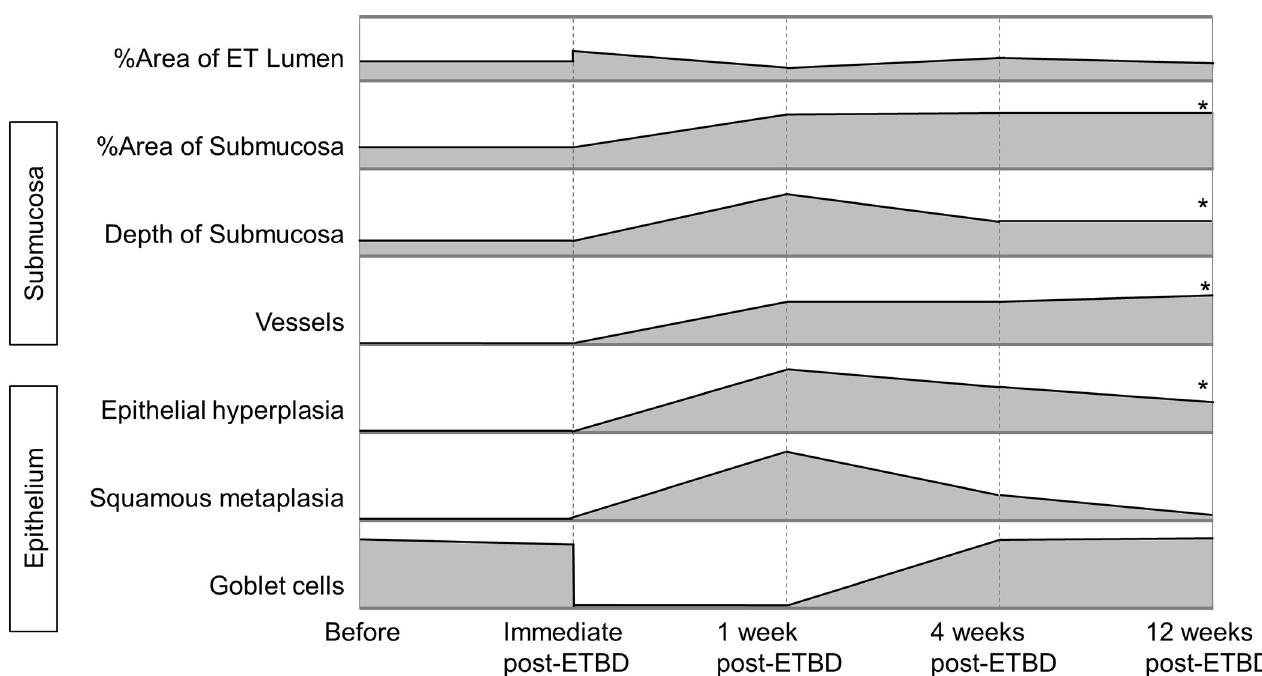
Fig 8. Histologic changes of the lumen of the rat ET, the submucosa and the epithelium. The asterisk denotes a significant difference between the period before surgery and at 12 weeks post-ETBD (p < 0.05, Mann Whitney U test).